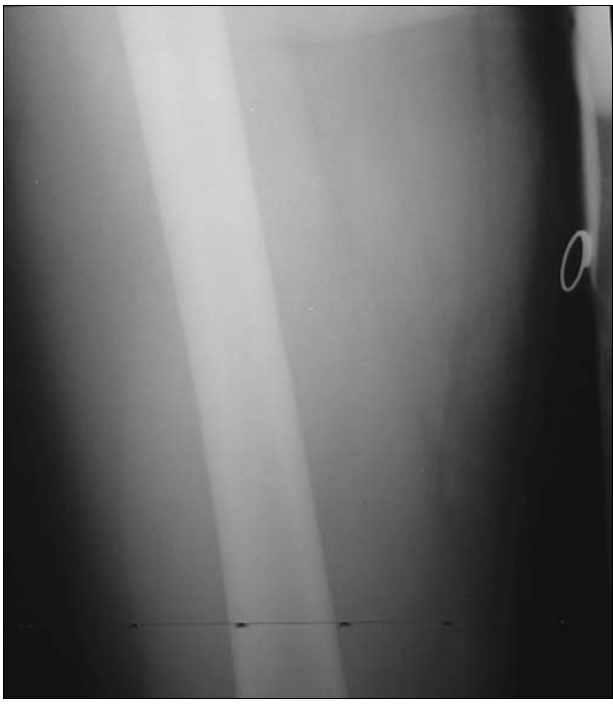
Fig. 2a. Right thigh with circular metallic skin-marker; Teflon felt not visible.